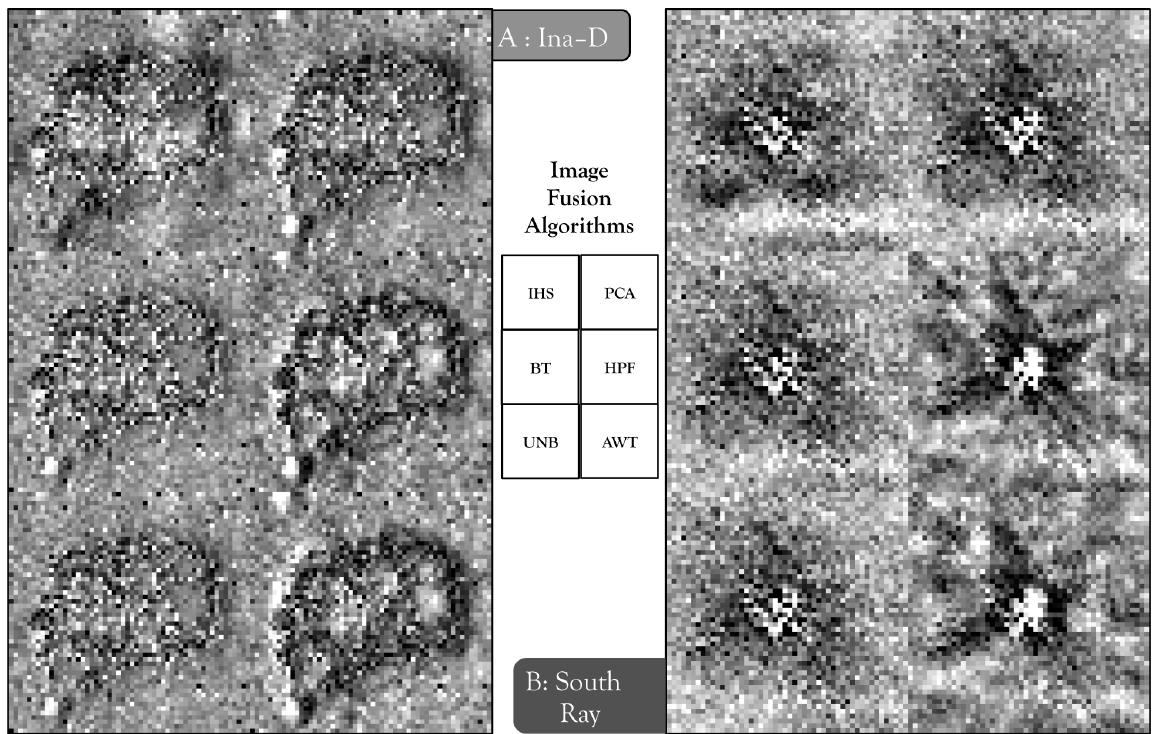
Figure 6: Image fusion results’ ratio images for LROC WAC UV 1 / Vis 1 band ratio. Contrast stretch limits saturate upper and lower 2% of pixel values of individual composite images.